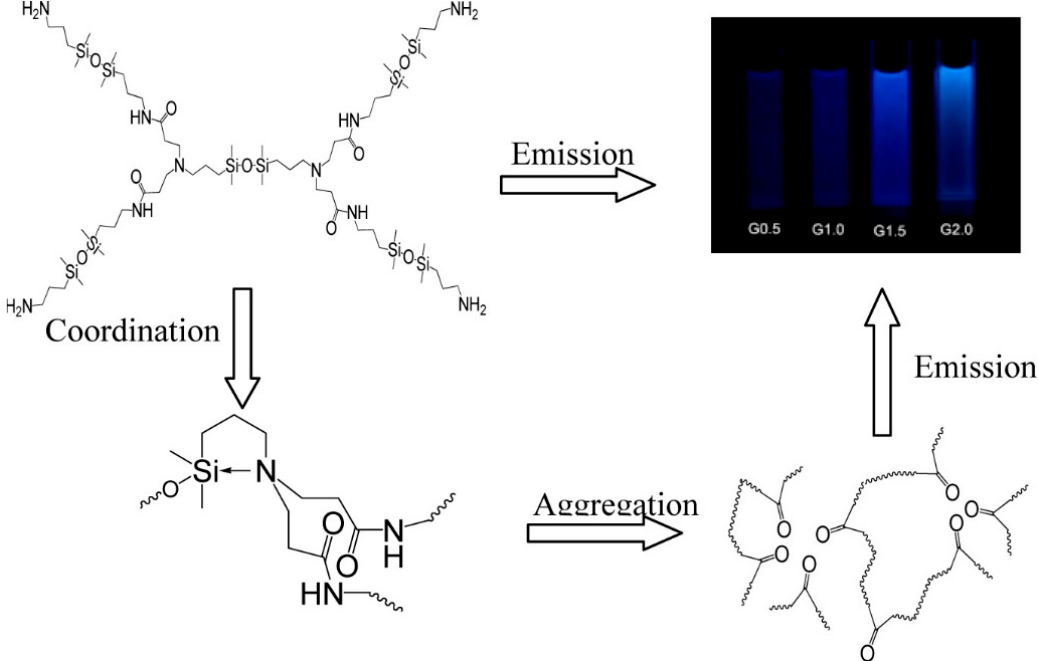
Figure 8. Scheme of the luminous mechanism of Si-PAMAM [5]. Copyright 2015, American Chemical Society.